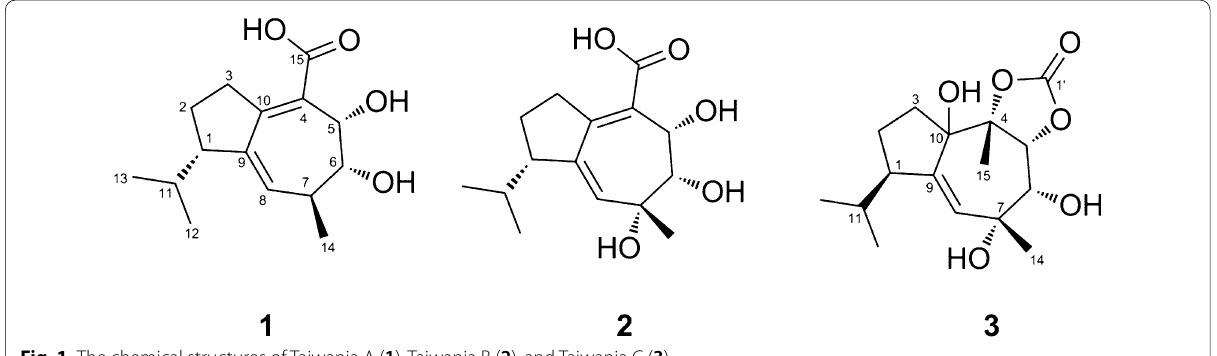
Fig. 1 The chemical structures of Taiwania A ( 1 ), Taiwania B ( 2 ), and Taiwania C ( 3